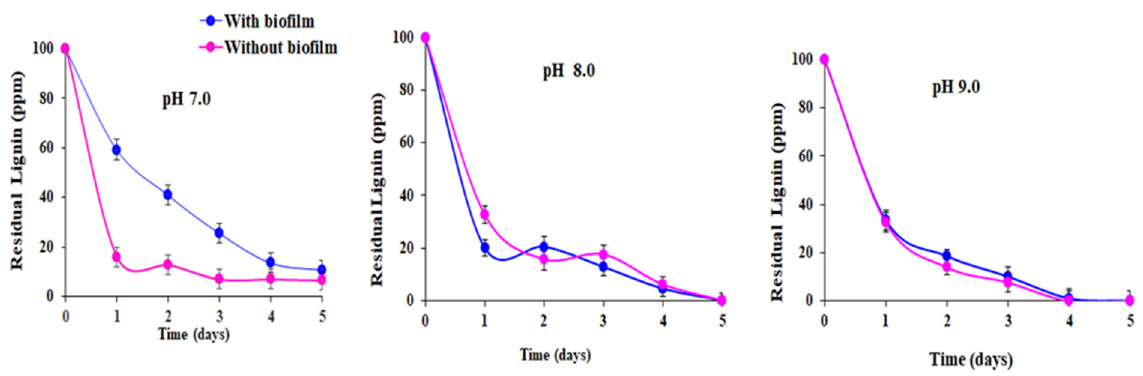
Figure 5. Lignin removal from the effluent by bacterial strain RGM2262 at the different pHs stud- ied.